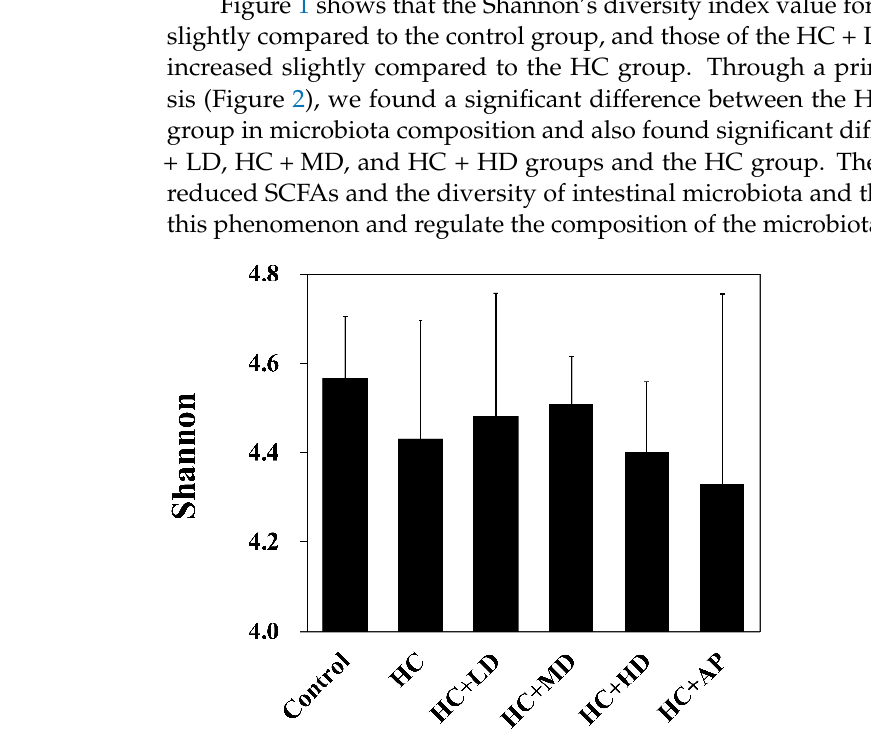
Figure 1. Alpha-diversity indices of richness of fecal microbiota compositions in rats with PO-induced hyperuricemia treated with TCI227. The Shannon index shows species richness and evenness. The reported values are means ± SD (n = 3). Significant difference among all the groups was not detected.